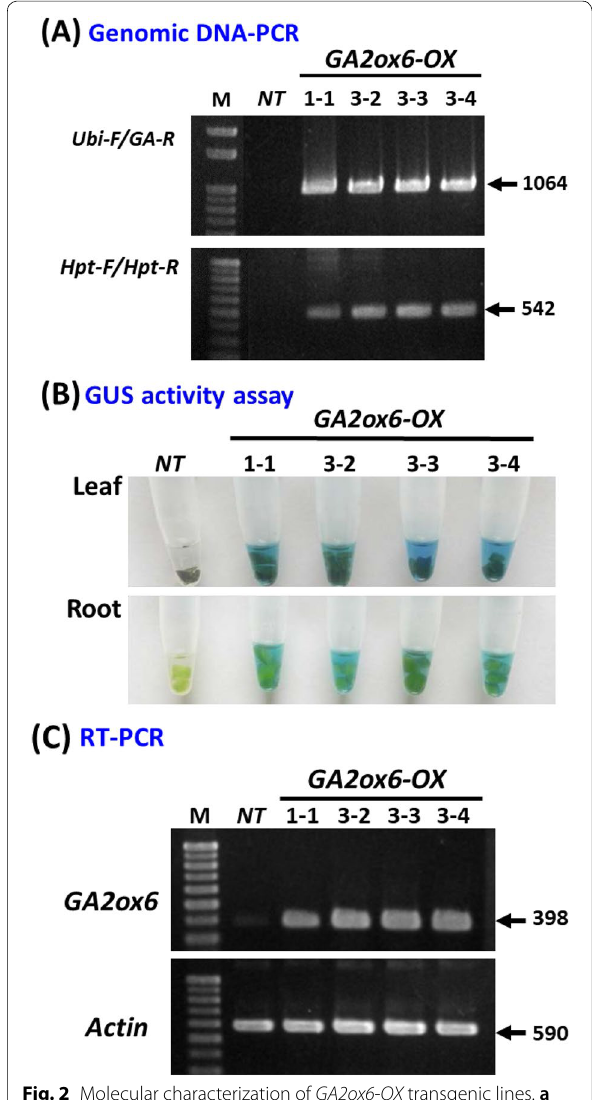
Fig. 2 Molecular characterization of GA2ox6 ‑ OX transgenic lines. a Genomic DNA PCR. Primers specific to the T‑DNA vector construct ( Ubi ‑ F/GA ‑ R ) and the Hpt gene ( Hpt ‑ F/Hpt ‑ R ) were used to verify the integration of the transgene. Four GA2ox6 ‑ OX transgenic lines, (#1‑1, #3‑2, #3‑3 and #3‑4), were analyzed. NT : nontransgenic line. b GUS activity assay. Leaf and root samples from the NT line and four GA2ox6 ‑ OX lines were analyzed. c RT‑PCR. The OsGA2ox6 transgene expression in the NT line and four GA2ox6 ‑ OX lines was analyzed